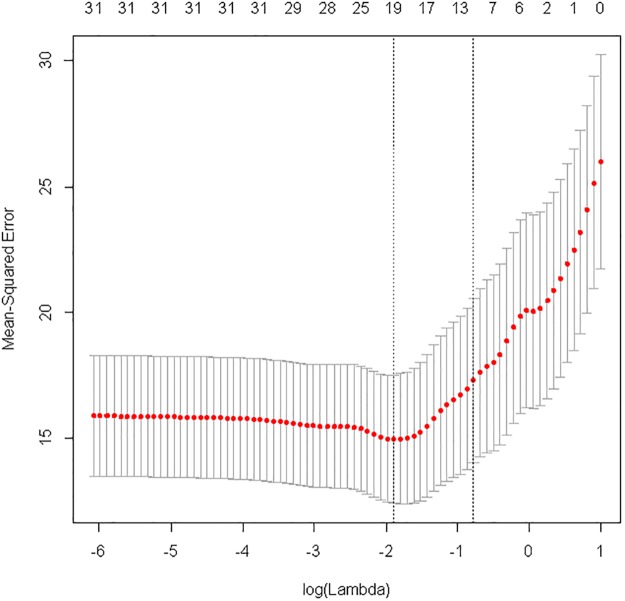
LASSO selection of optimal model of established risk markers and biomarkers: cross validated mean squared error (Y-axis; red bullets; MSE) vs. amount of restriction (X-axis; log(Lambda)).Vertical bars refer to standard errors across the 82 cross-validations. The best cross-validated MSE was obtained after inclusion of 19 variables (step 31), which included baseline UACR, MMP7, current vs. never smoker, sex, TEK, MMP2, systolic blood pressure, baseline eGFR, TNFR1, NPHS2, CTGF, use of oral diabetic medication, YKL-40, MMP1, MMP13, MMP8, SOST, CCL2, and NT-proCNP.